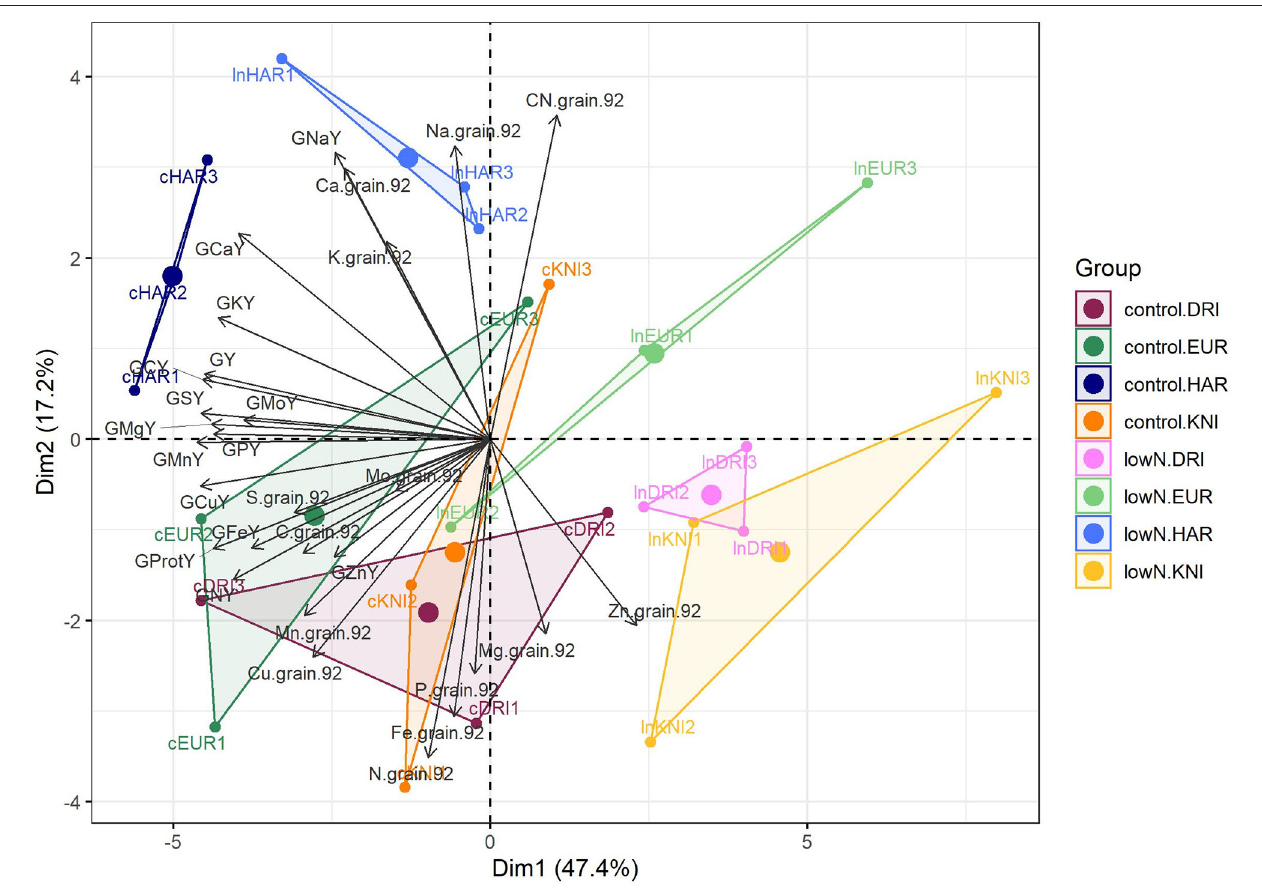
FIGURE 5 | Principal component analysis of grain nutrient compositions and yields at harvest in four varieties of field-grown durum wheat (Kiko Nick, Don Ricardo, Euroduro, and Haristide) at two N levels (control vs. low N). The abbreviations are described in Supplementary Table 1 .